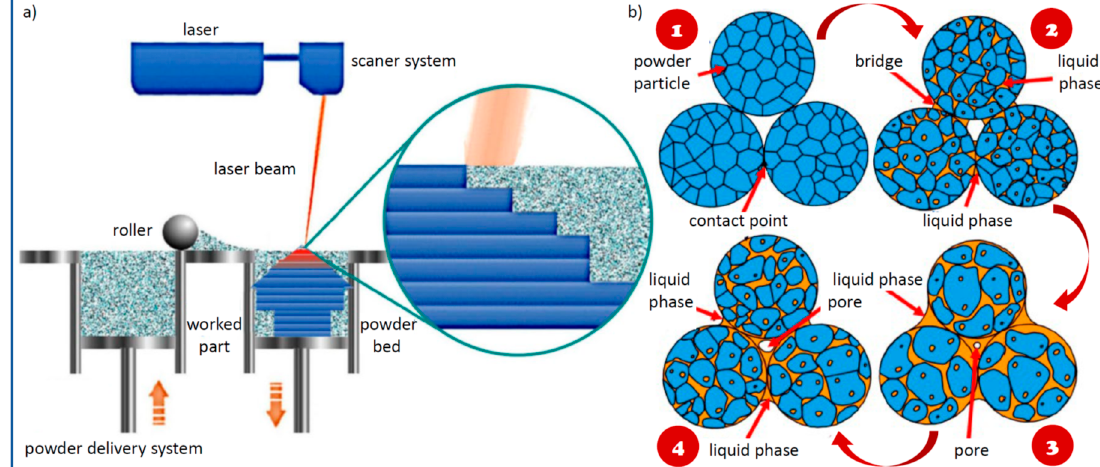
Figure 27. Diagram ( a ) Selective laser sintering methods; ( b ) the successive stages of liquid phase sintering.